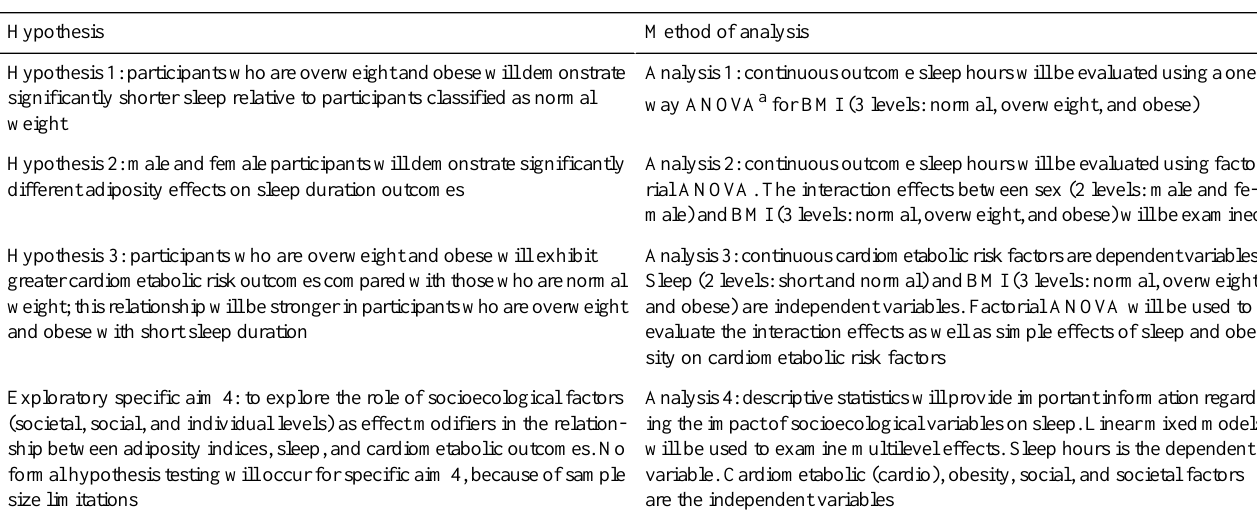
Table 1. Hypotheses and methods of analysis.